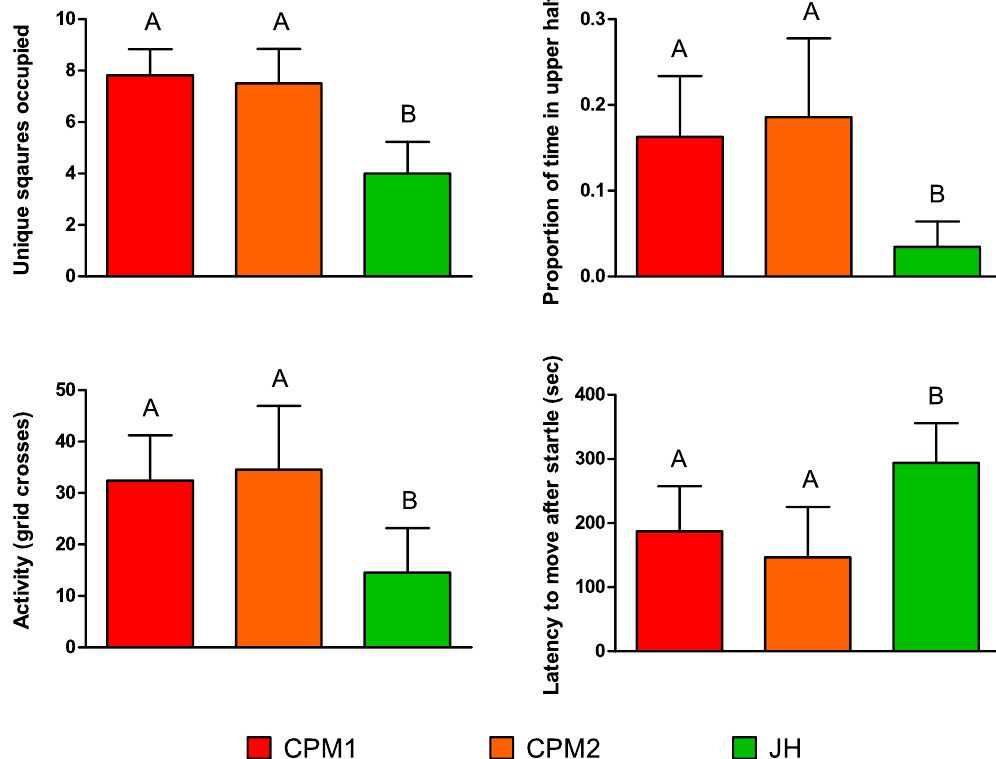
Figure 2. The behaviour displayed in the assays performed on caged goldfish from Cootes Paradise Marsh (CPM) and Jordan Harbour (JH) (n = 48, Bar = Mean response, Error Bars = 95% CI). Differences in unique squares occupied and latency to move after startle were assessed using linear models. The proportion of time in upper half was assessed using a beta regression, and activity (grid crosses) using negative binomial generalized linear